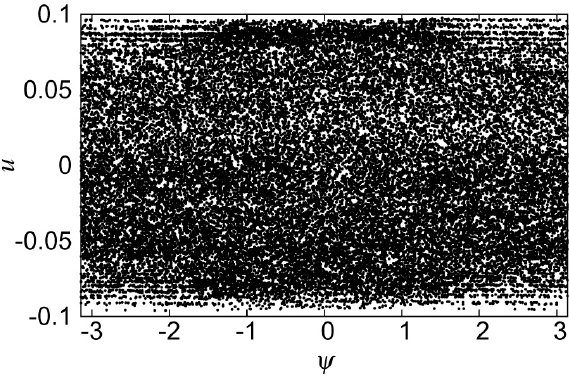
Fig. 12. Strange attractor of the map (121) at Q = 1 . 1 × 10 − 3 .